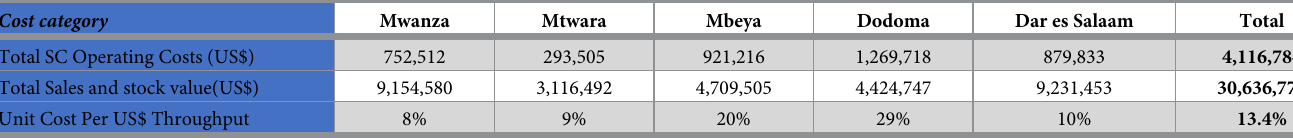
Table 4. Average unit costs of supply chain operations at the MSD zones (2020